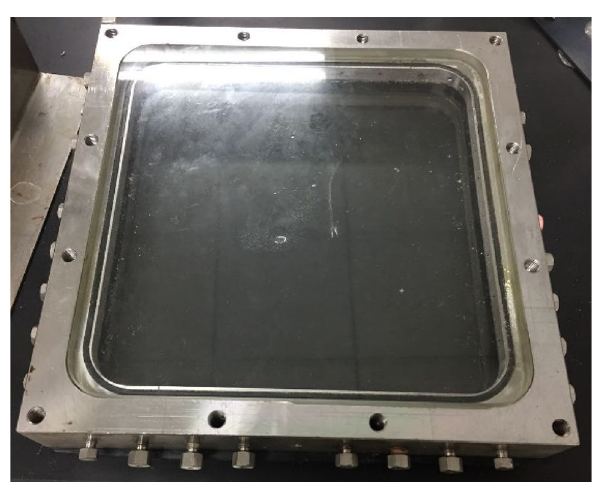
Fig. 2 Two-dimension visualization plate